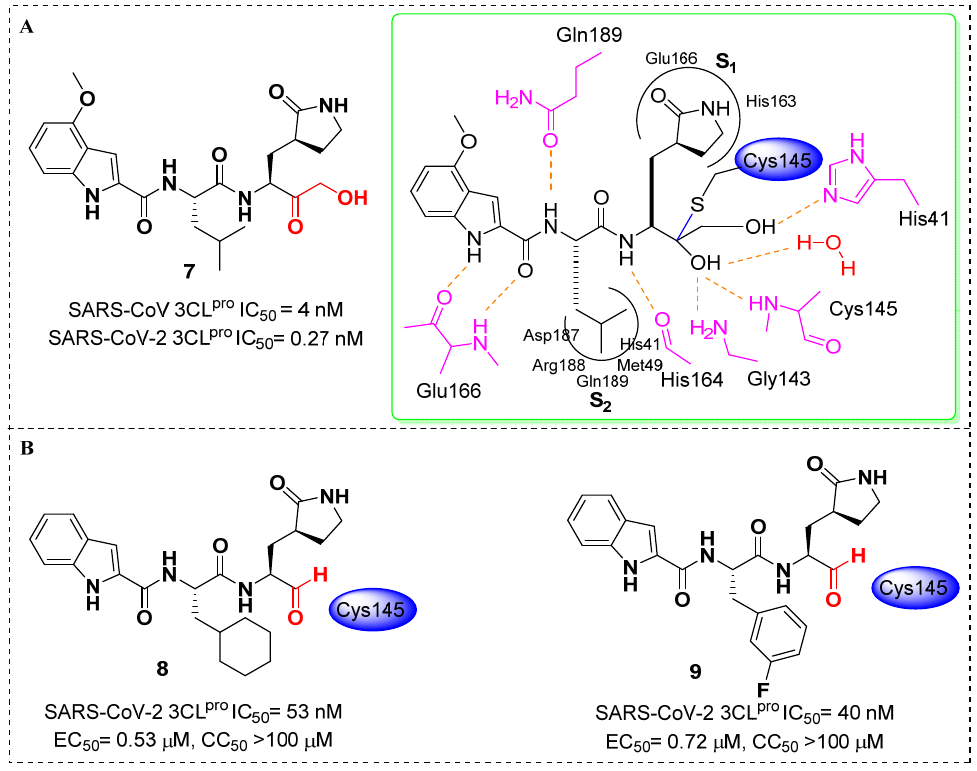
Figure 5. ( A ) Chemical structure of 7 and the schematic rendering of the active site with dashed lines represented as hydrogen bonds with key residues and curved lines to show S1 and S2 binding pockets [25]; ( B ) chemical structures of 8 and 9 ; inhibitory activities against SARS-CoV-2 3CL Pro (IC 50 ) and in vitro inhibition of 3CL Pro (EC 50 ) [26].